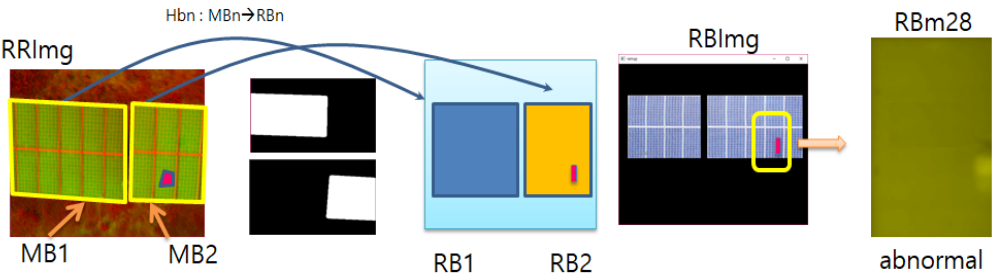
Figure 3. Feature points extraction and matching images creation through corresponding points.